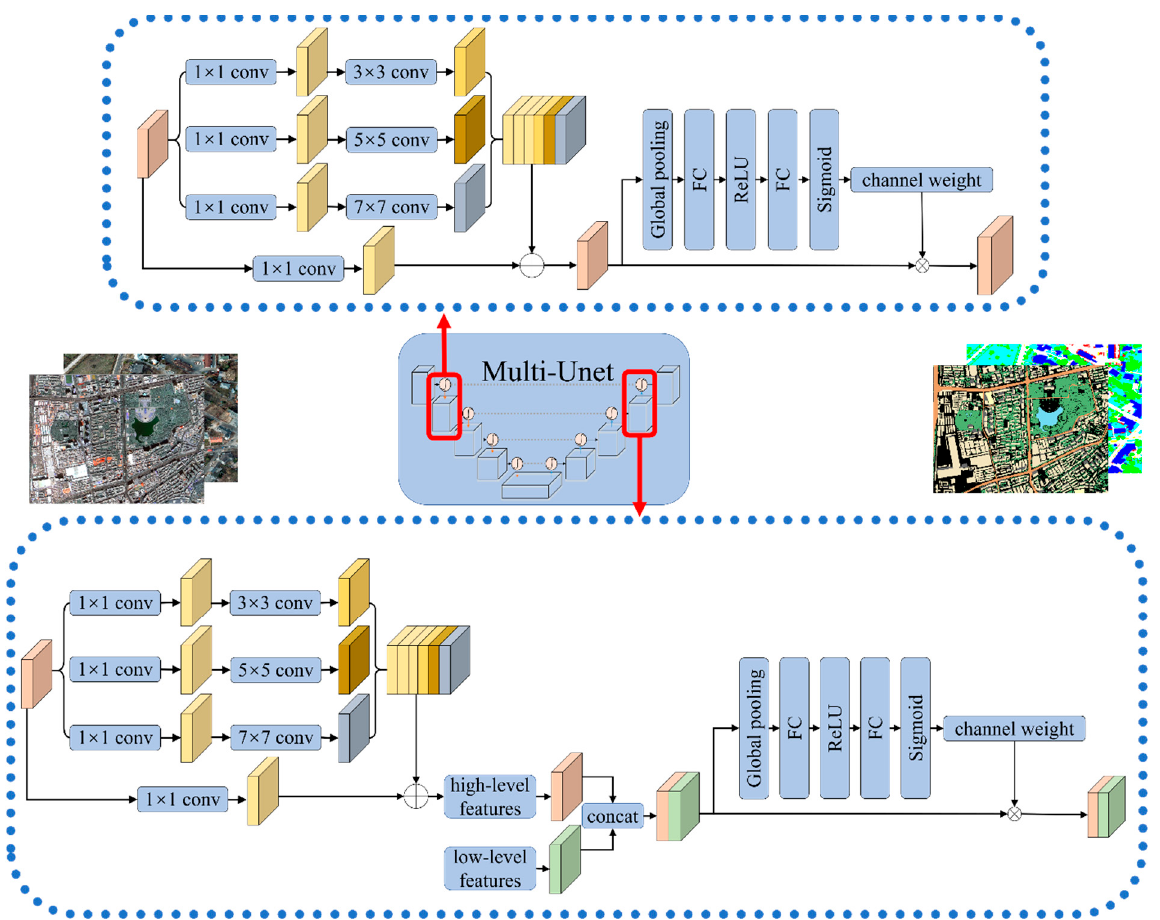
Figure 3. Multi-U-Net network structure.